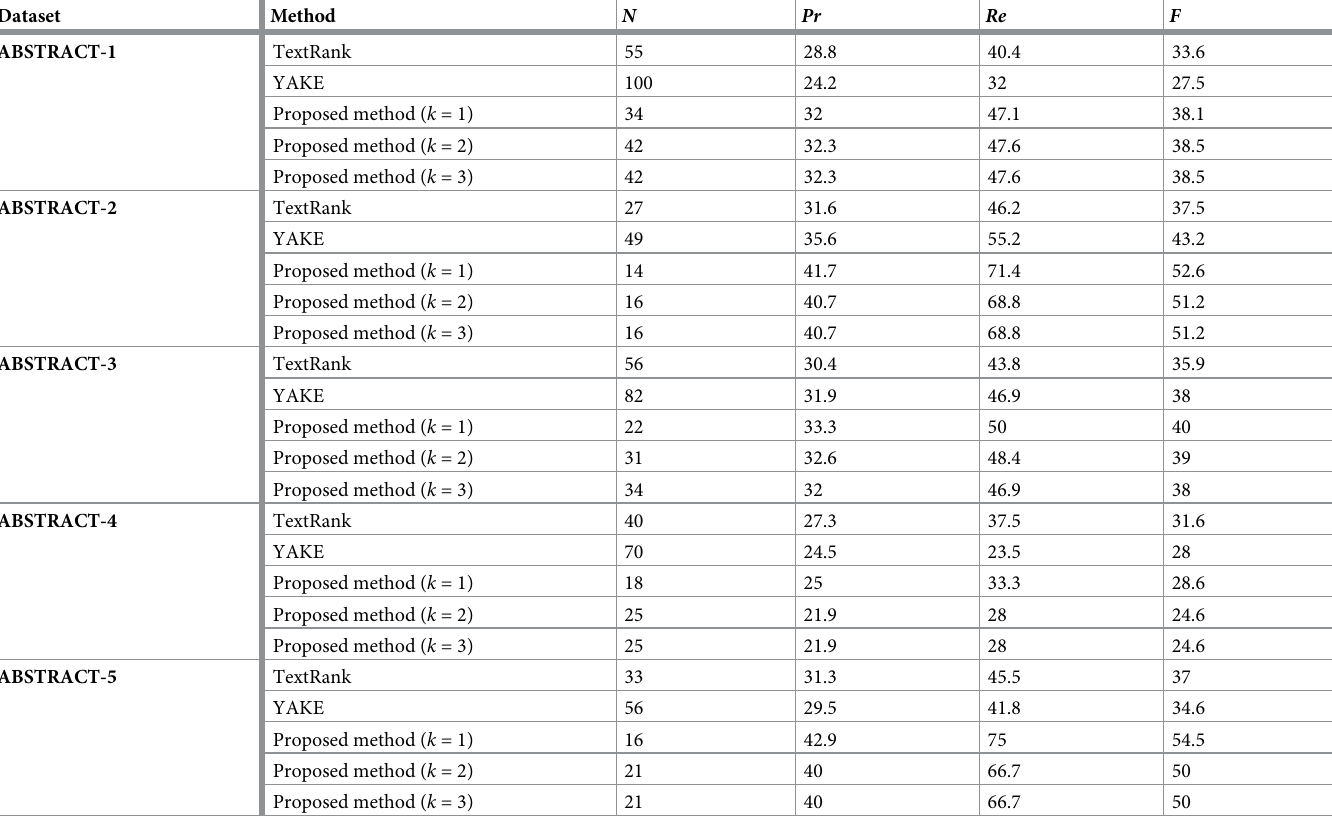
Table 9. Comparison of multiple keyword extraction methods against human